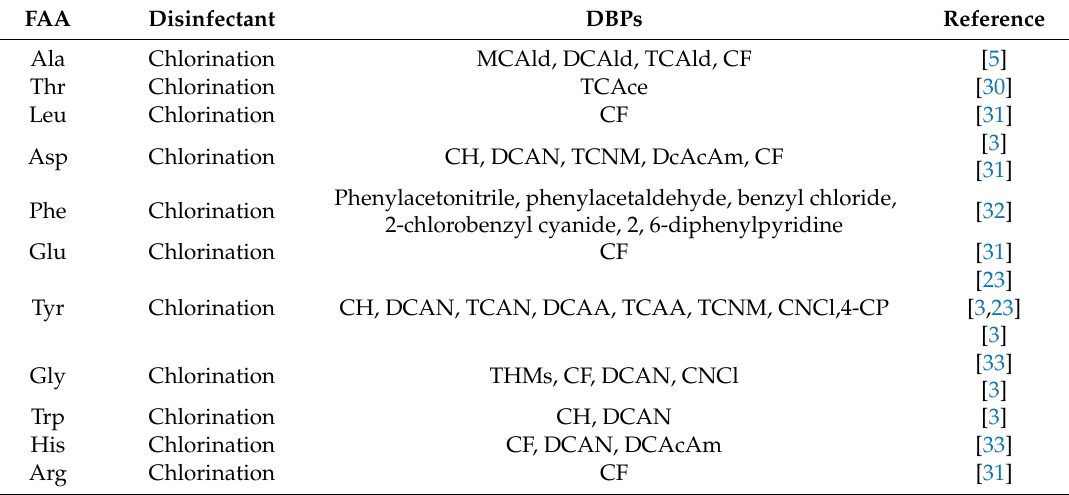
Figure 5. The disinfection byproduct formation potential of Tyr, Phe, Glu, and Asp during chlorination. TCM = trichloromethane; DCAA = dichloroacetic acid; TCAA = trichloroacetic acid; DCAN = dichloroacetonitrile; TCMN = trichloronitromethane. Table 6. FAAs and corresponding disinfection byproducts (DBPs).